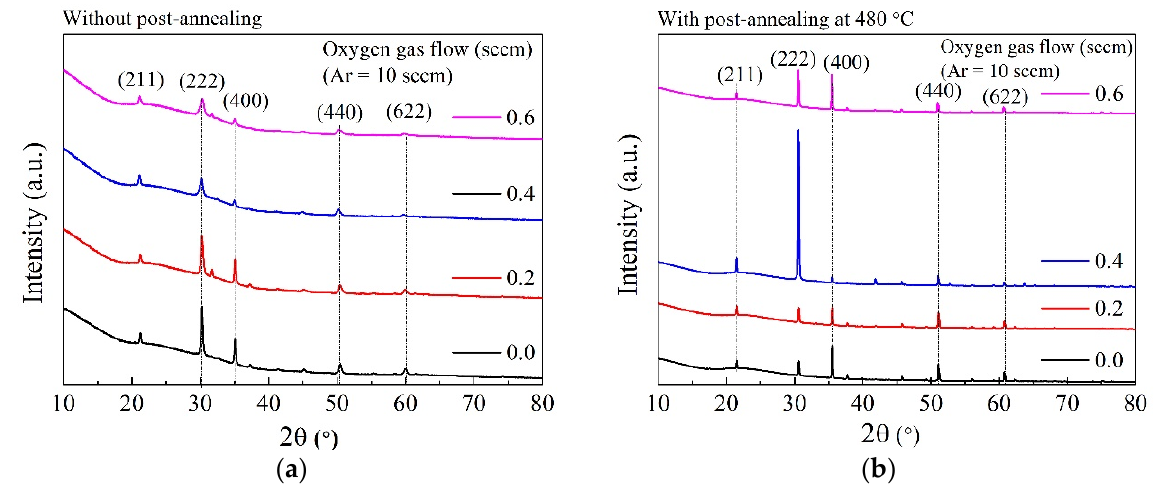
Figure 4. XRD patterns of ITO films prepared at various rates of oxygen-gas flow ( a ) without post-annealing and ( b ) with post-annealing at 480 °C. Table 2. Summary of properties for (222) in ITO films.